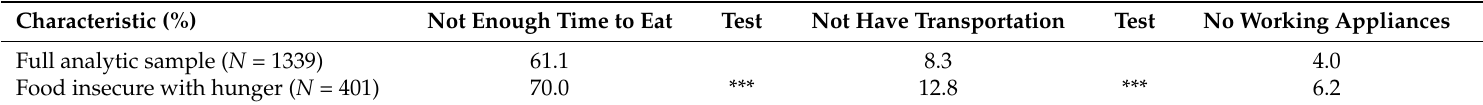
Table 4. Variation in challenges among students who are food insecure with